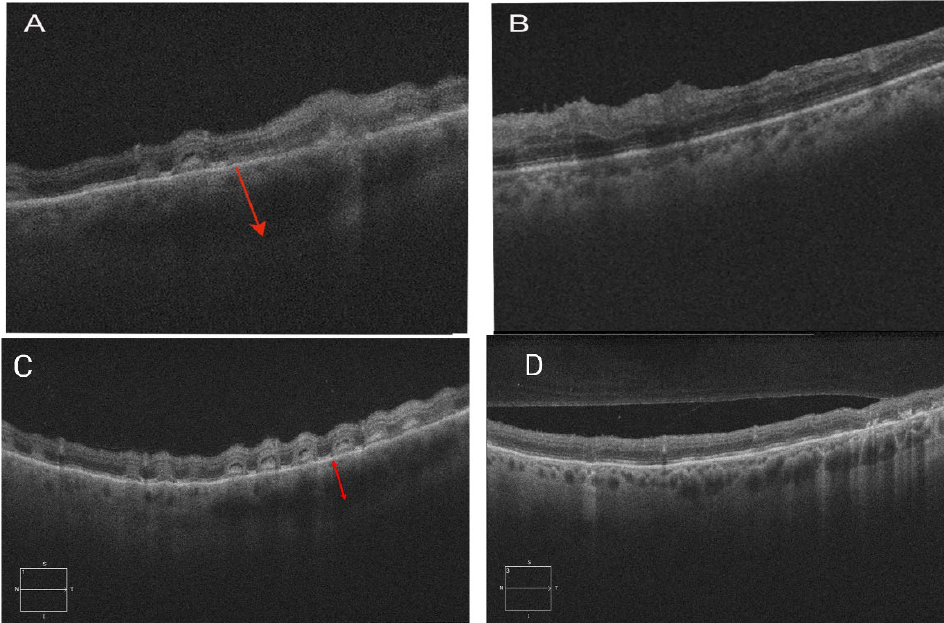
Figure 2. OCT images of all three patients acquired immediately after ( A , C , D ) and 1 month after ( B ) PRP. This demonstrates choroidal detachment immediately after PRP in ( A , C , D ) that resolves by 1 month after PRP ( B ), which is 1 month following Patient A. Red arrow in A and C indicates choroidal thickness measurement immediately after PRP.